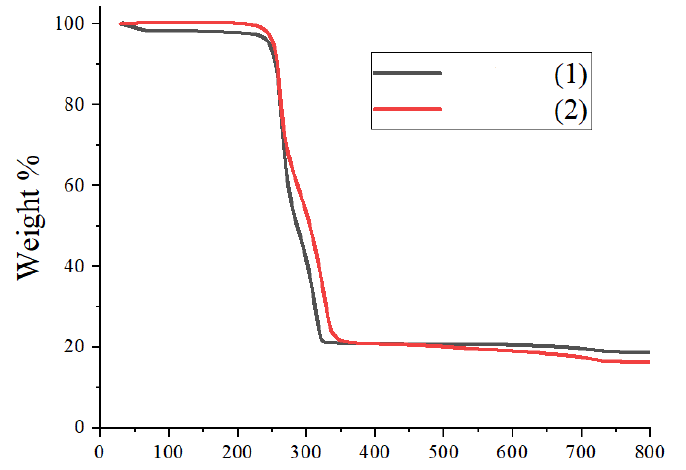
Figure 4. Superimposed thermogravimetric analysis (TGA) profile for complexes 1 and 2 .